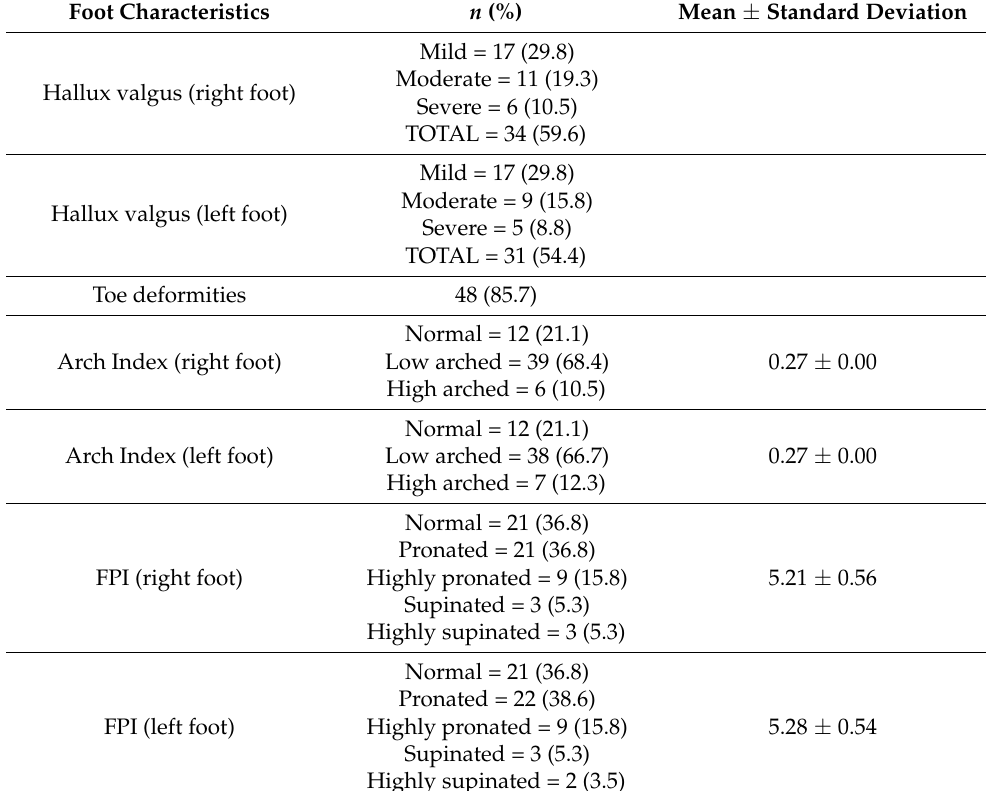
Table 1. Participants’ feet characteristics.